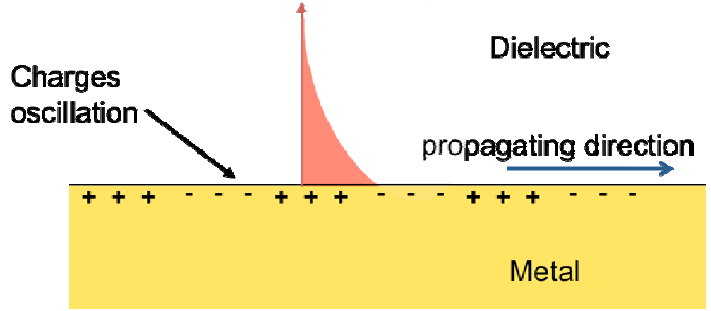
Figure 5. A schematic for surface plasmon resonances traveling along the tangential direction at the interface between a dielectric and a metallic layer. The enhanced electric field reaches its maximum at the interface and decays exponentially from the